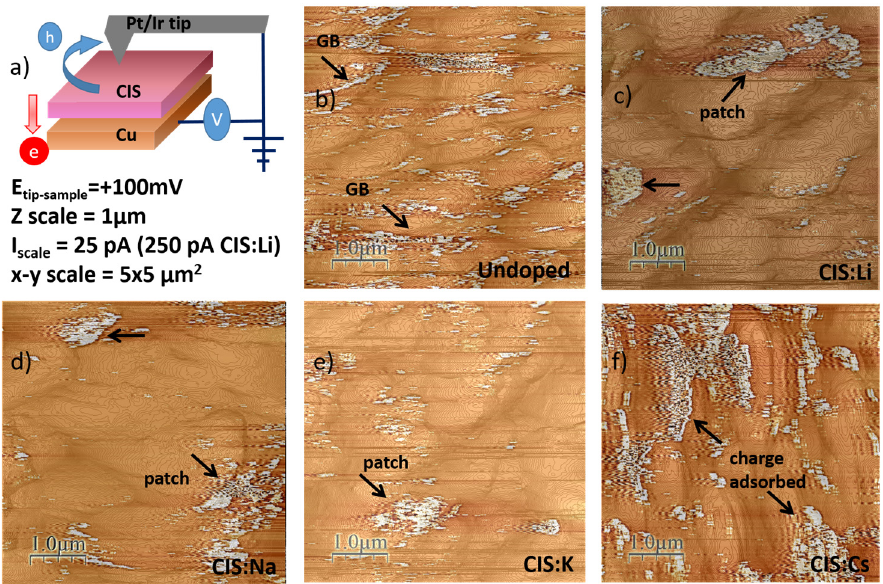
Figure 4. ( a ) Scheme of the setup of the CAFM measurement and summary of experimental conditions and image characteristics. Over-imposed topography and current images of the films. Arrows indicate current flow paths, ( b ) CIS, ( c ) CIS:Li, ( d ) CIS:Na, ( e ) CIS:K, ( f ) CIS:Cs.